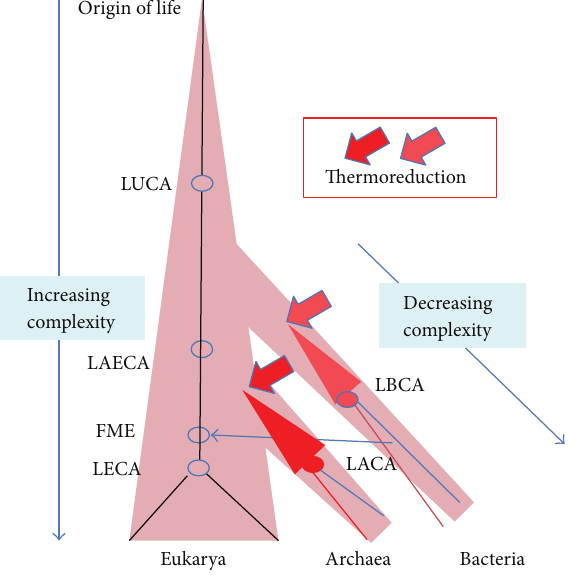
Figure 3: A scenario based on divergent evolutionary trends for “prokaryotes” (archaea and bacteria) and eukaryotes. This scheme is based on the assumption that the universal tree is rooted in the bacterial branch [53]. Complexity increased from the origin of life to LUCA to eukaryotes, via the last archaeal-eukaryal common ancestor (LAECA). Reductive evolution occurred from LAECA to LACA and modern archaea, possibly triggered by thermoreduction [77] indicated by large red triangles and/or as a way to escape protoeukaryoticpredators[50].Bacteriaexperiencedindependently a similar evolutionary path. The blue arrow indicates the mitochon- drial